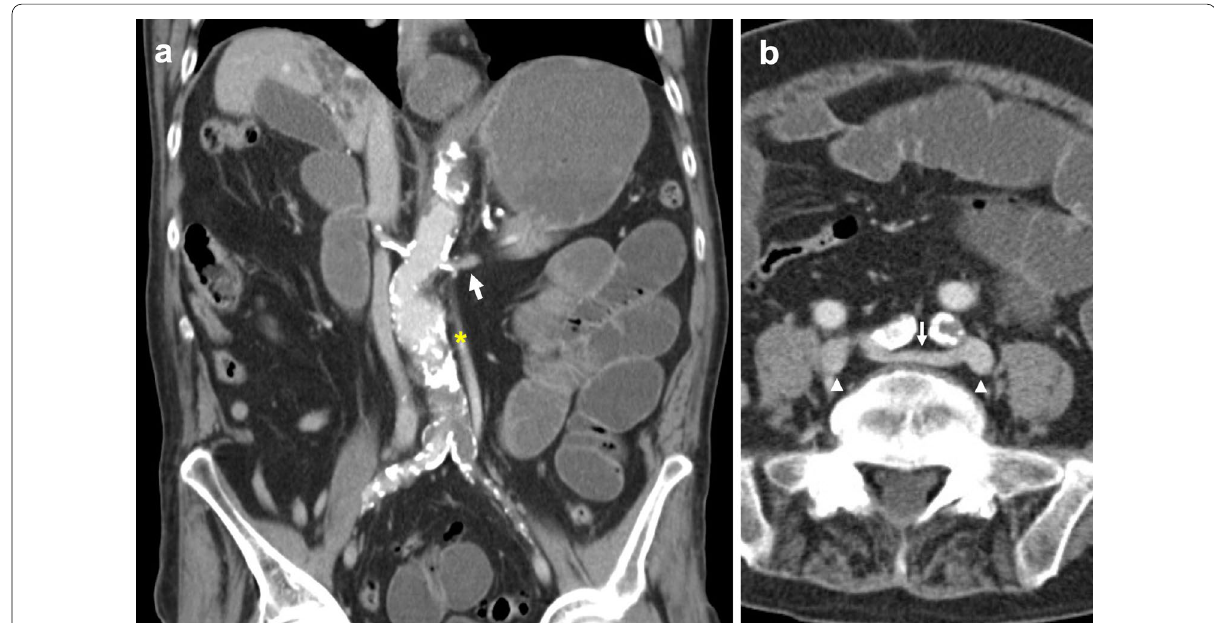
Fig. 4 Duplicated IVC with asymmetrical caliber and bridging vein. a Contrasted-enhanced coronal CT shows a duplicated IVC (asterisk) of smaller caliber compared to the orthotopic IVC, that approaches and subsequently drains into the left renal vein (arrow). b Axial CT image shows a bridging vein (arrow) connecting paired common iliac veins (arrowheads) positioned anterior to the L4 vertebral body and posterior to common iliac